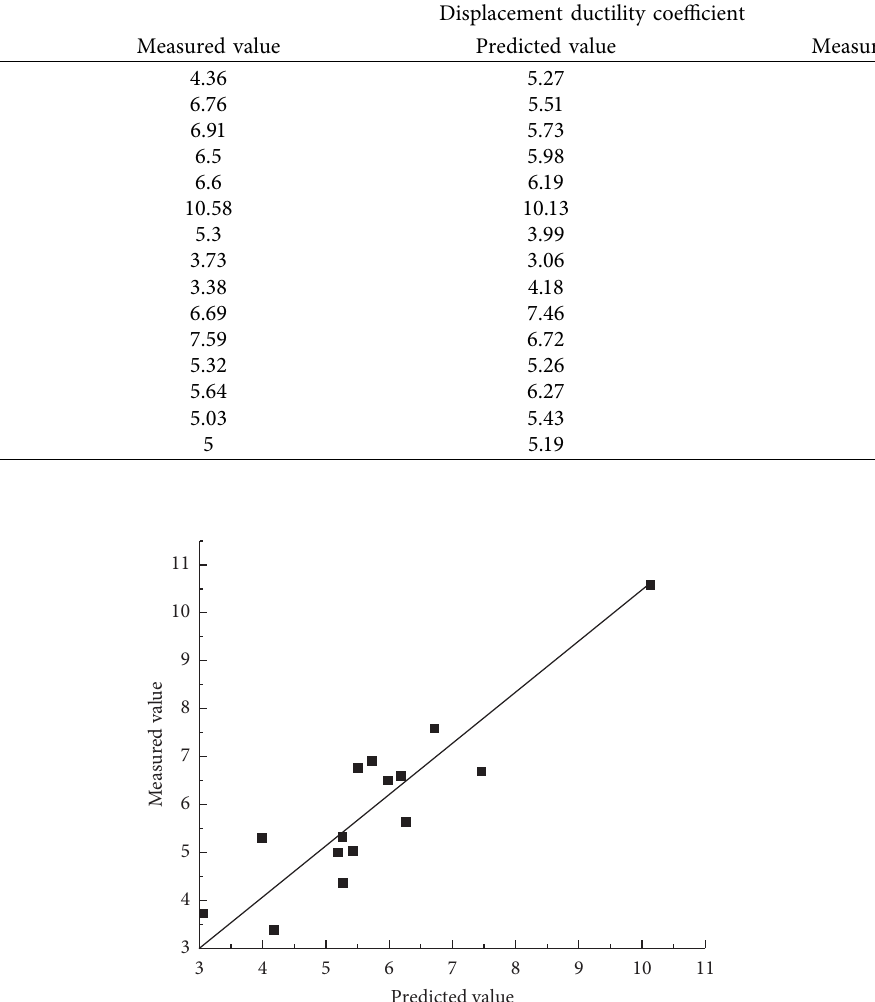
Figure 6: Ratio of measured value and predicted value of displacement ductility coefficient (Table 10). Table 11: Predicted value fit of the proposed formula.